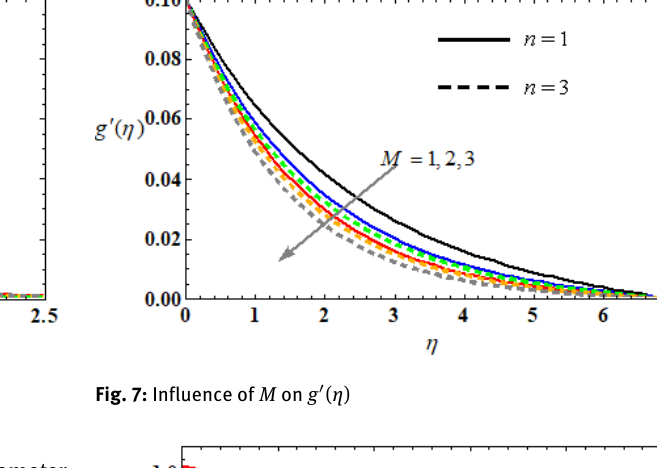
Figures 2–5 depict the variation of Casson parameter ( β ) on the non-dimensional velocity, temperature and con- centration, respectively. It is observed from the figure that fluid flow decreases with an increase in Casson fluid pa- rameter, while the temperature as well as concentration of the fluid decreases with an increase in Casson param- eter β . The influence of the magnetic field on the velocity profiles, temperature and concentration is present respec- tively in Figures 6–9. The magnetic parameter is found to retard the velocity at all points of the flow field. The bound- ary layer thickness decreases with an increase in the mag- netic parameter. It is obvious that the effect of increasing values of M results in a decreasing velocity profiles across the boundary layer. The temperature and concentration of the fluid increases due to rise in the values of magnetic pa- rameter M .